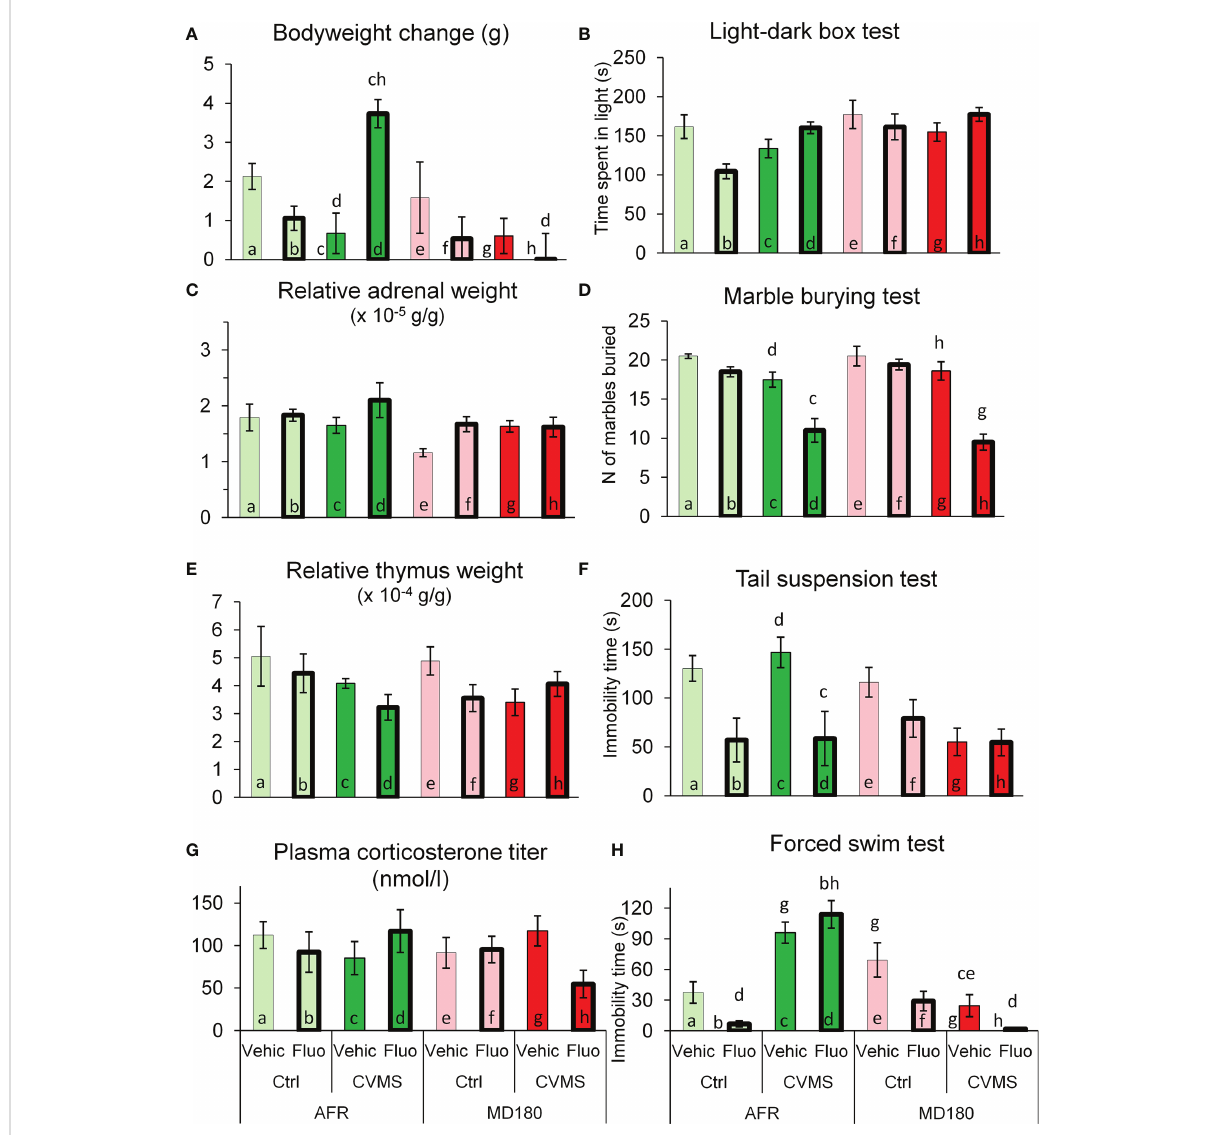
FIGURE 2 Summary of physical, endocrinological parameters and behavioral test results. (A) Bodyweight change of groups in the period of chronic variable mild stress (CVMS) between PD125 and perfusion (PD140), expressed in grams (g). (C) Relative adrenal tissue weight expressed in grams per bodyweight grams (x 10 -5 g/g). (E) Relative thymus tissue weight corrected for bodyweight, expressed in grams per bodyweight grams (x 10 -4 g/g). (G) Blood corticosterone titers (nmol/l). (B) Time spent in the illuminated compartment during light-dark box test expressed in seconds (s). (D) Number of marbles buried in the marble burying test. (F) Immobility time in tail suspension and (H) forced swim test, expressed in seconds (s). AFR: animal facility-reared, MD180: 180-min of maternal deprivation. Ctrl: control (i.e. not exposed to CVMS); Vehic: physiological saline; Fluo: fl uoxetine. Lettering at the top of bars represents the most relevant signi fi cant post hoc statistical differences between pairs of groups